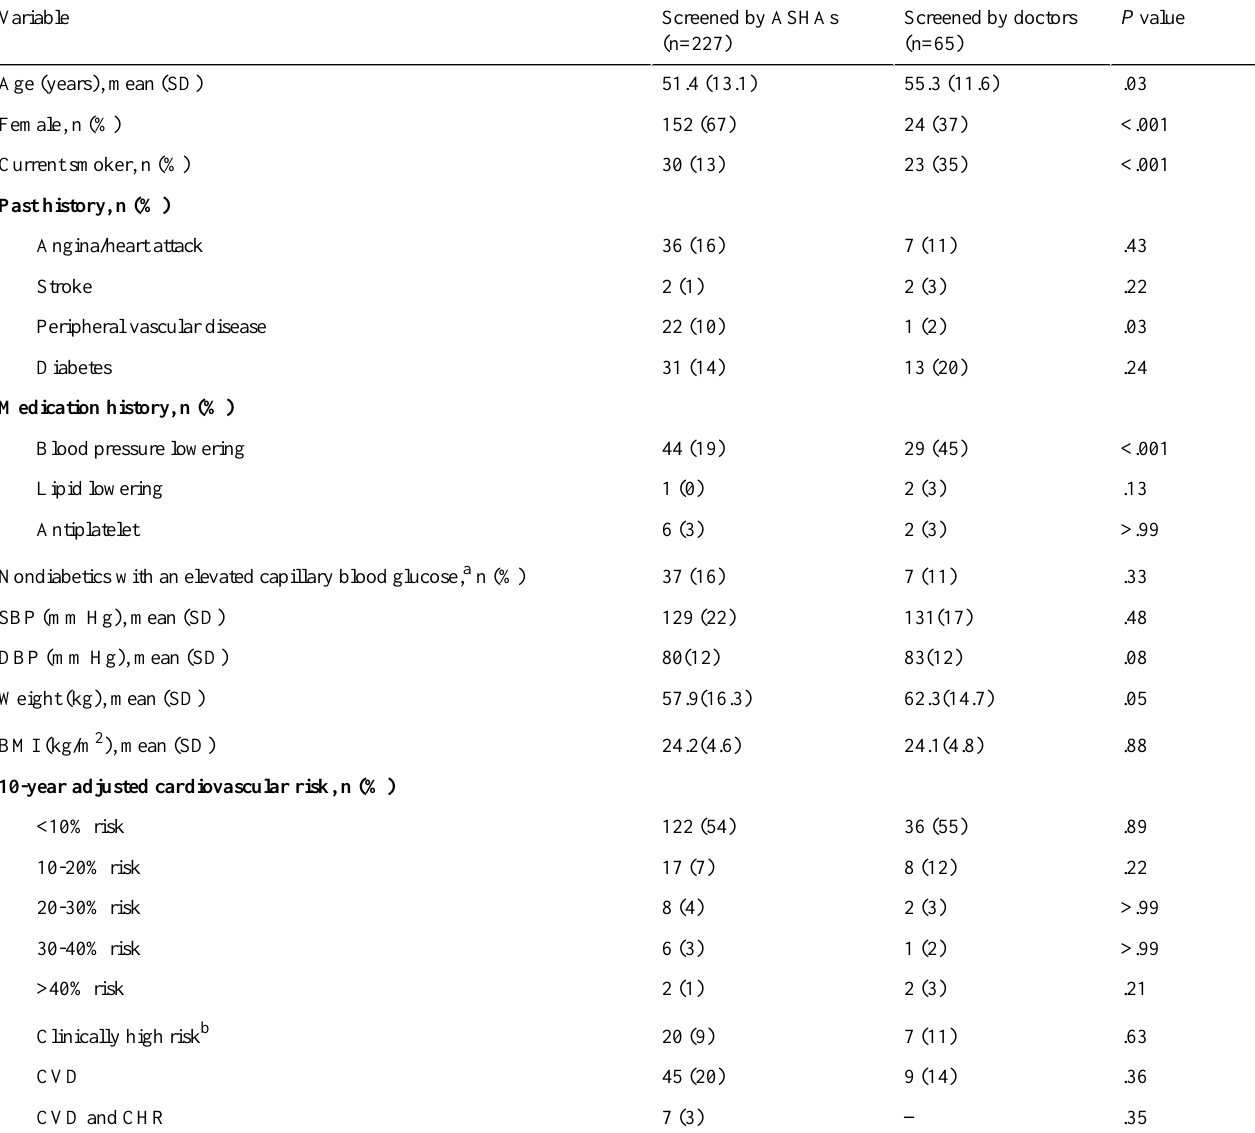
Table 2. Cardiovascular risk factor profile for participants screened by ASHAs (n=227) and doctors (n=65).